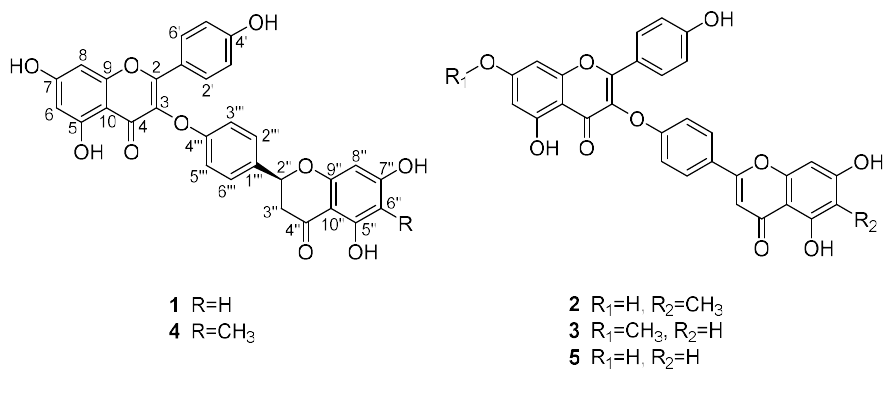
Figure 1. Structures of compounds 1-5